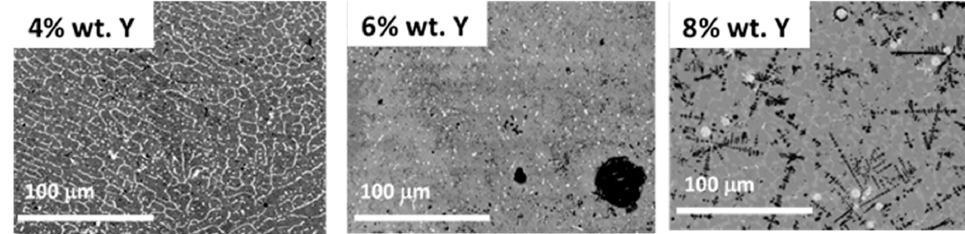
Figure 1. Backscattered micrographs of the as synthesized alloy of Ti-Fe + x wt.% Y ( x = 4, 6, and